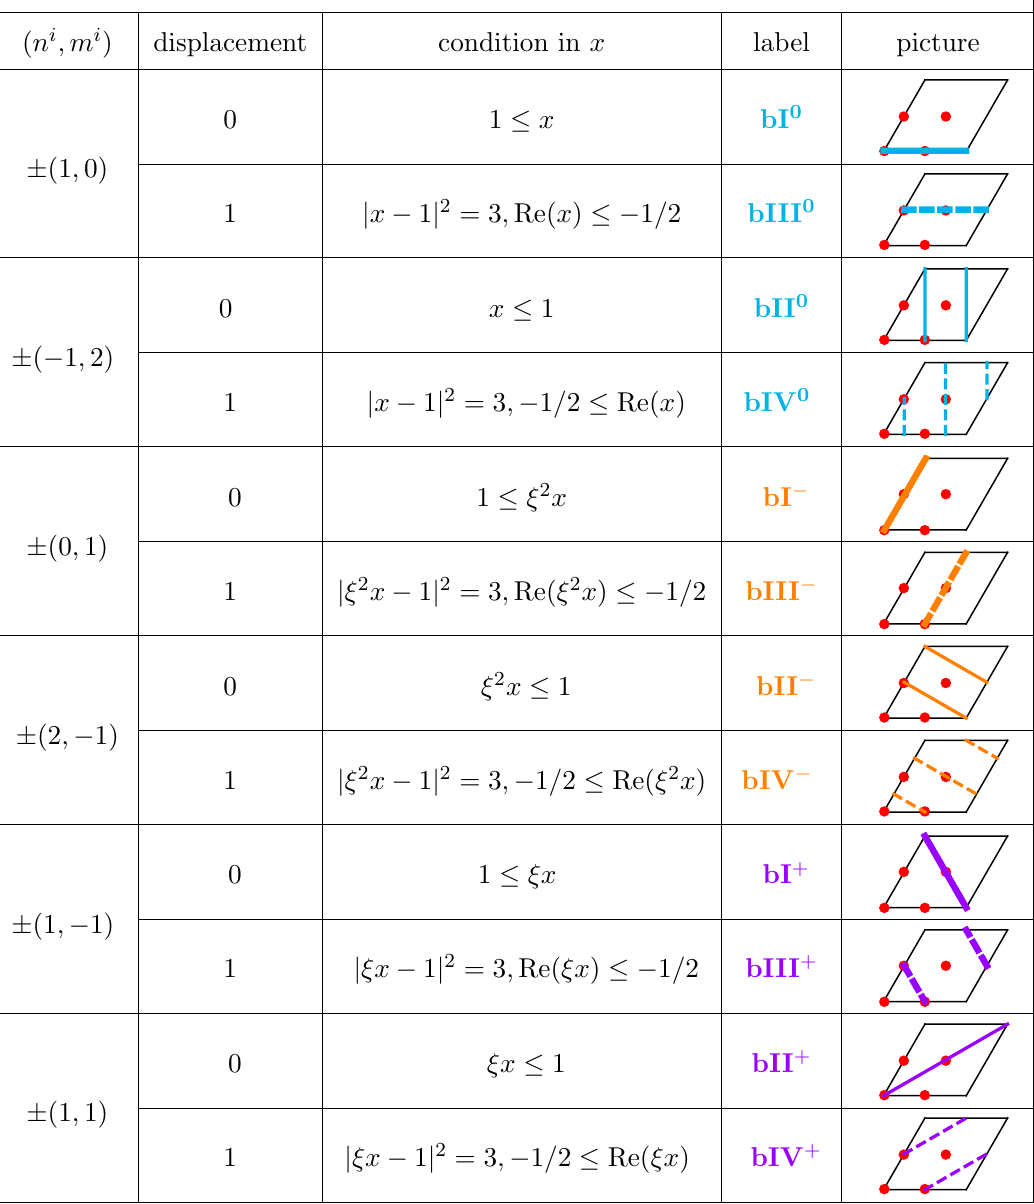
Table 6 . Overview of Lag one-cycles on an elliptic curve corresponding to a hexagonal two-torus. The (cid:12)rst column lists the torus wrapping numbers ( n i ; m i ) describing how the one-cycles wrap on the two-torus lattice, while the second column indicates a potential displacement along one of the basis one-cycles. The third column presents the equation for the Lag line in the homogenous coordinate x (considering the v = 1 patch) in line with (cid:12)gure 2 (b). The last column gives a graphical representation of the Lag one-cycle on the two-torus